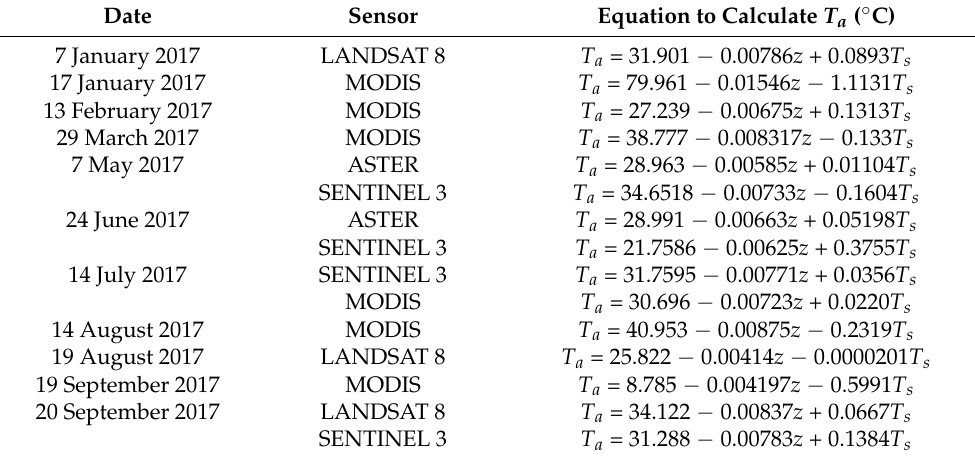
Table 3. Multiple regression equations to calculate T a .